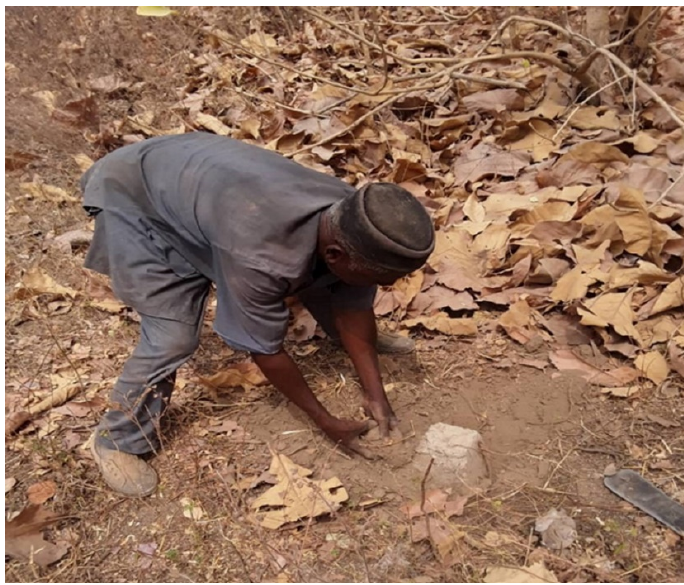
Figure 5. Monumentation of a boundary by an owner.